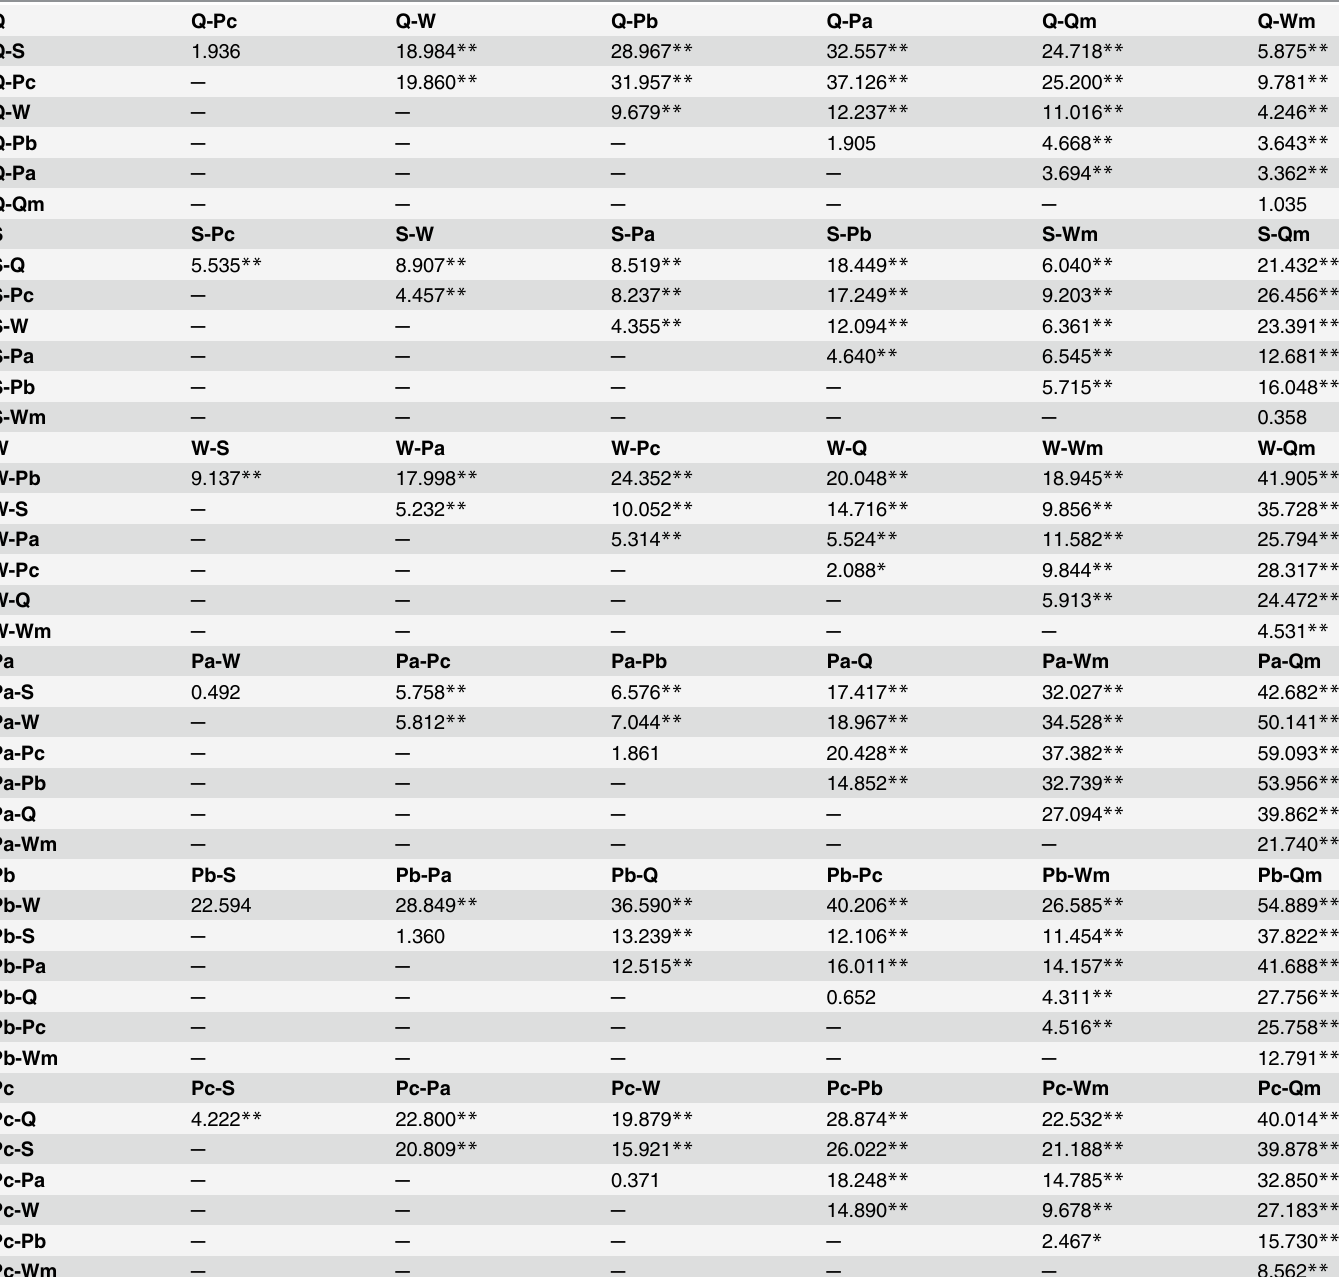
Table 2. Pairwise comparisons computed on mean Euclidean distances of sounds emitted by ants and